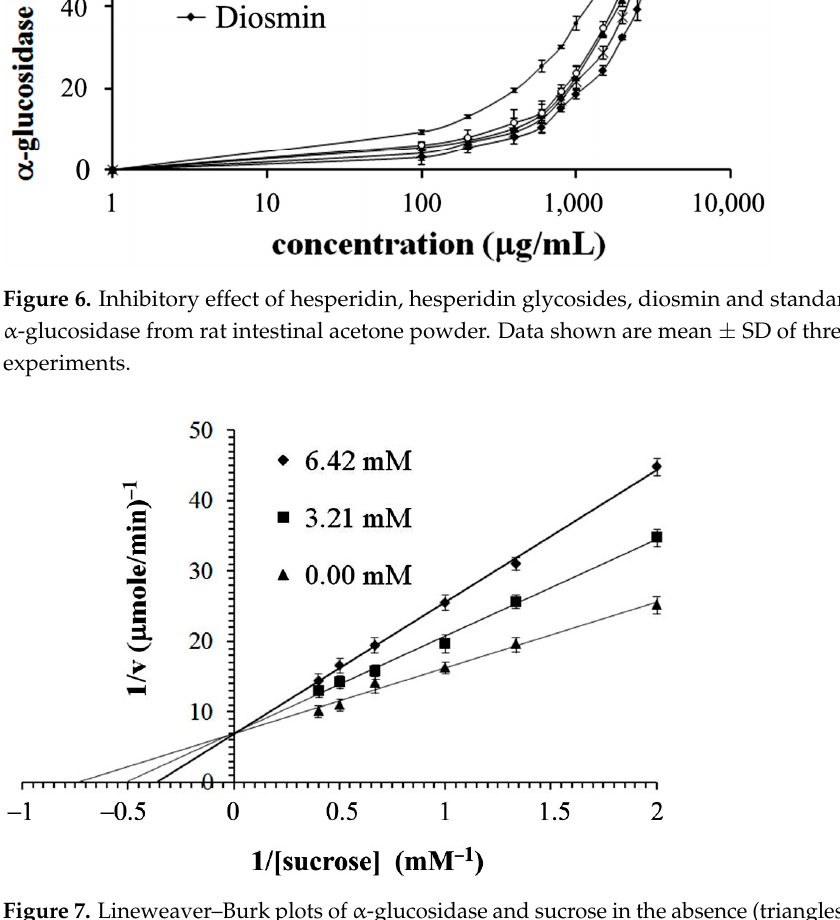
Figure 7. Lineweaver–Burk plots of α -glucosidase and sucrose in the absence (triangles) and presence (squares and diamonds) of HG 2